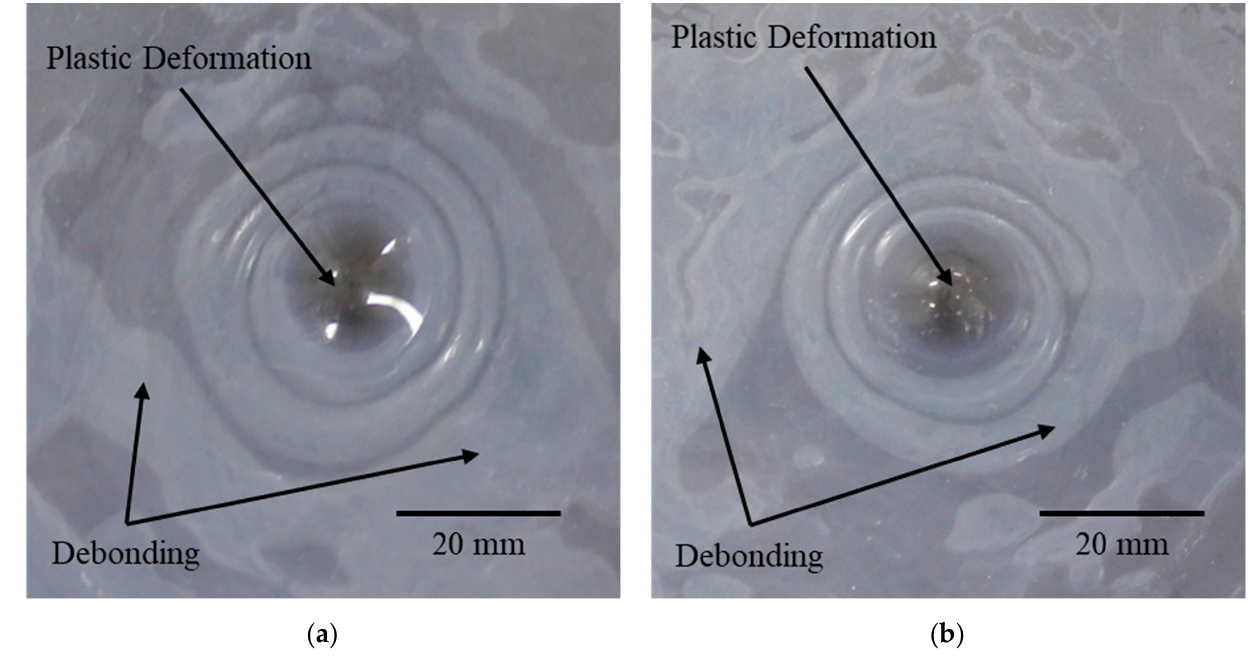
Figure 11 . Layered PC specimen at 120 J impact energy ( a ) top view and ( b ) bottom view. Figure 11. Layered PC specimen at 120 J impact energy ( a ) top view and ( b ) bottom